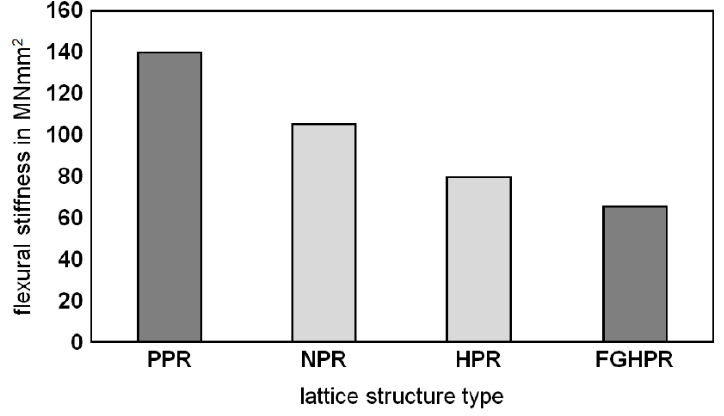
Figure 14. The flexural stiffness of the PPR, NPR, HPR, and FGHPR lattice structures.